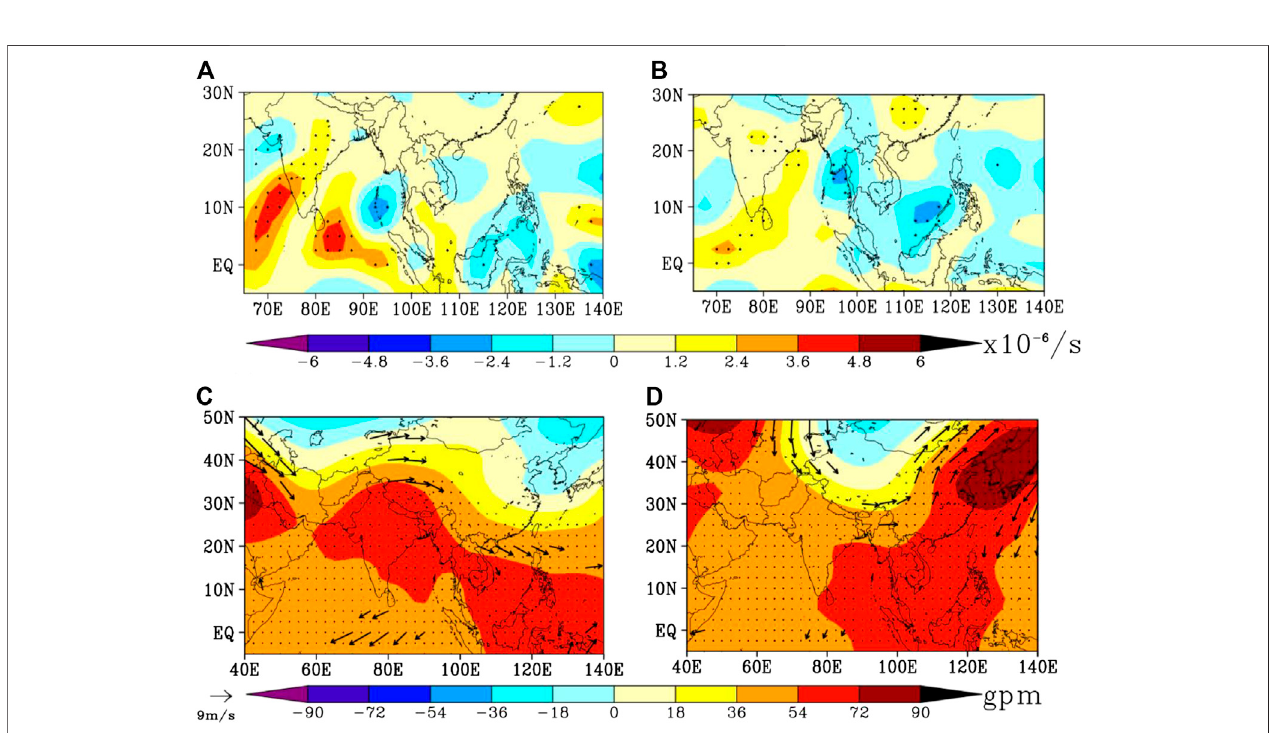
FIGURE 7 | Composite differences of (upper) the divergence anomaly (shaded; unit: s-1) and (bottom) geopotential height (shaded; unit: gpm) and horizontal wind (vector; unit: m/s) anomaly at 150 hPa in May between positive and negative years of PC1 for the period of (left) 1958 – 1979 and (right) 1980 – 2018. The positive (negative) years of PC1 are higher (lower) than 0.5 ( − 0.5). The stippling and black vectors denote values exceeding the 90% con fi dence level.